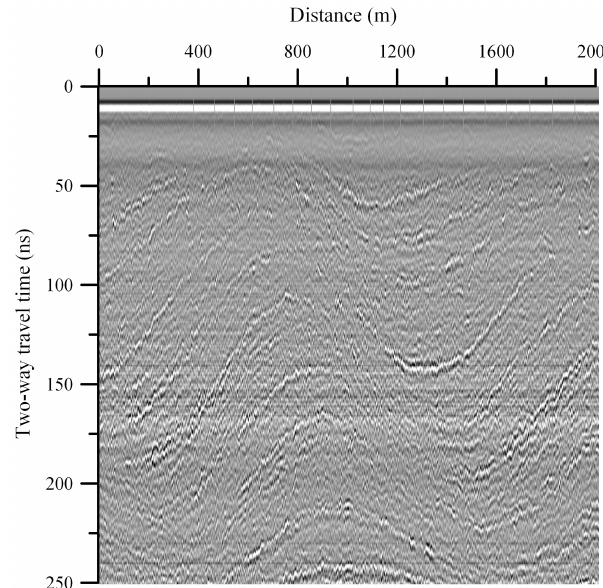
Figure 2. GPR registration recorded along the MD00